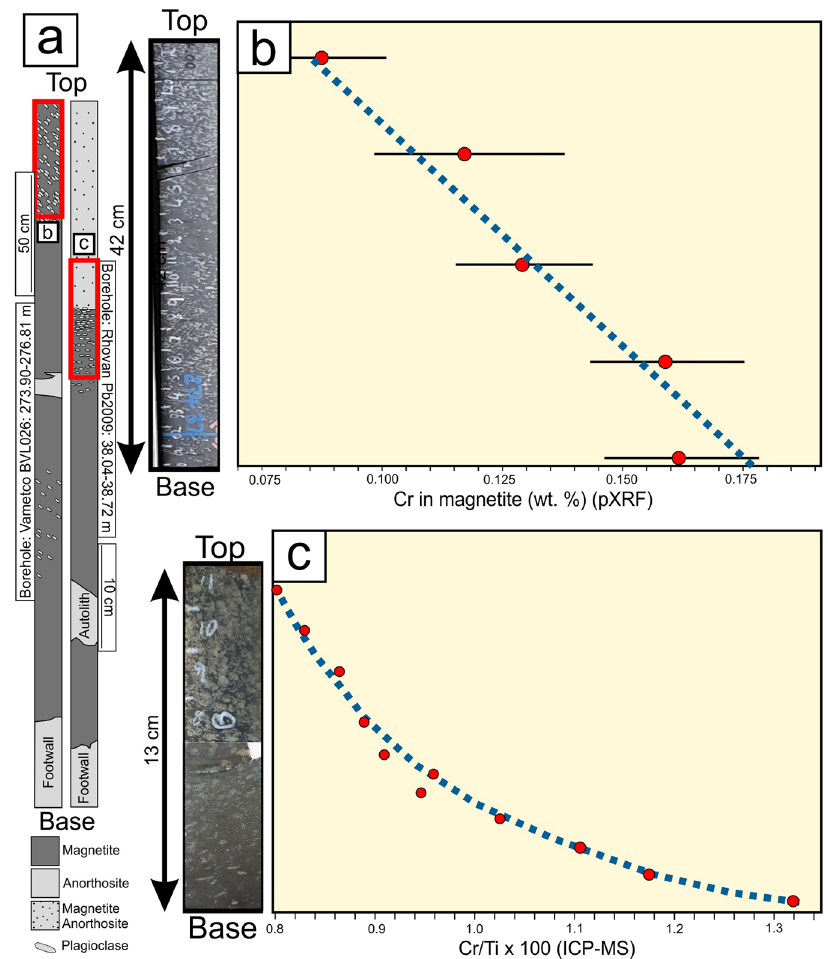
Fig. 5 Cr in magnetite across the upper gradational contacts of magnetitite layers from the Vametco mine in the Western Limb. a Sketches of drill cores with the analyzed sections highlighted in red. As in Fig. 4, the anorthositic footwall can be seen in both examples and anorthositic autoliths are present in both magnetitite layers. A complete gradation to magnetite – anorthosite can be seen atop the Bottom Seam (BS) in the Rhovan drill core. b A rapid but regular depletion in Cr upwards is observed across a thick gradational contact of the MML from Vametco. Horizontal lines indicate 2 Θ error bars. c Detailed analysis across the upper gradational contact of the Main Magnetite Layer from Vametco. Notice the steep, but remarkably regular depletion in Cr upwards. Cr/Ti ratios are plotted to exclude any feldspar contamination that may be present (methods). Error bars (2 Θ ) for these analysis are too small to show on the fi gure. Blue lines are fi t by hand to highlight the trend of Cr